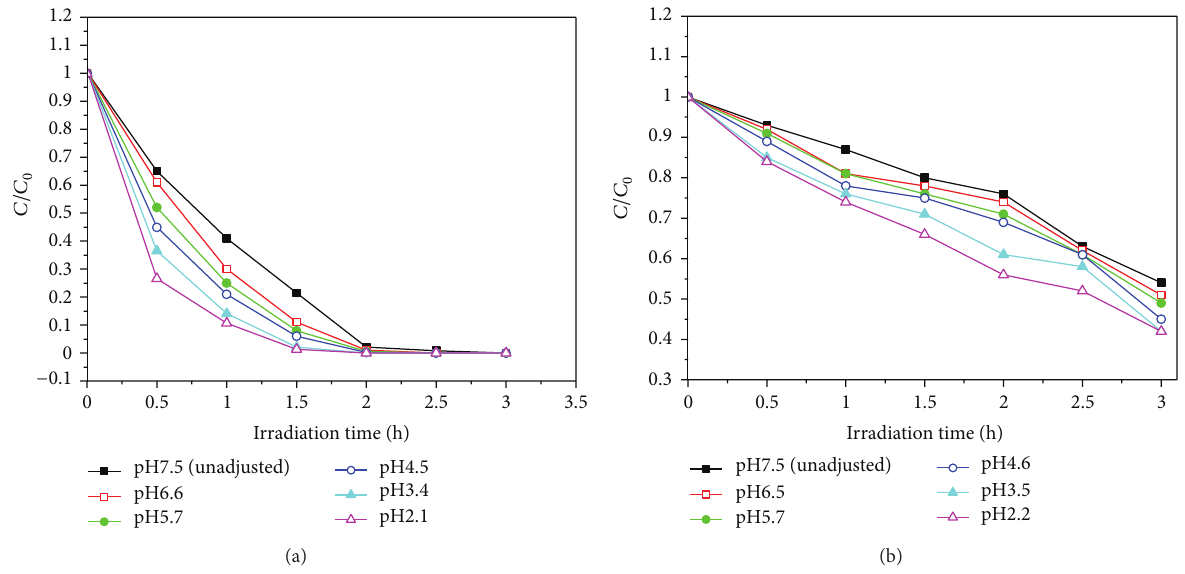
Figure 6: The photocatalytic activity of Fe-TNT-1 (a) and pure TNT (b) with different pH under visible light irradiation.